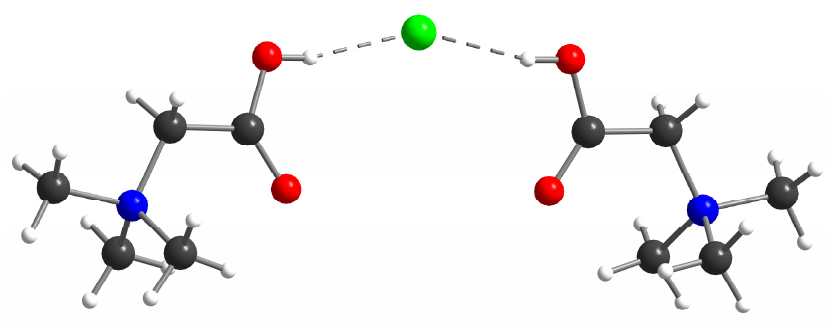
Figure 3. Hydrogen bond mediated, chloride bridged cationic dimer.